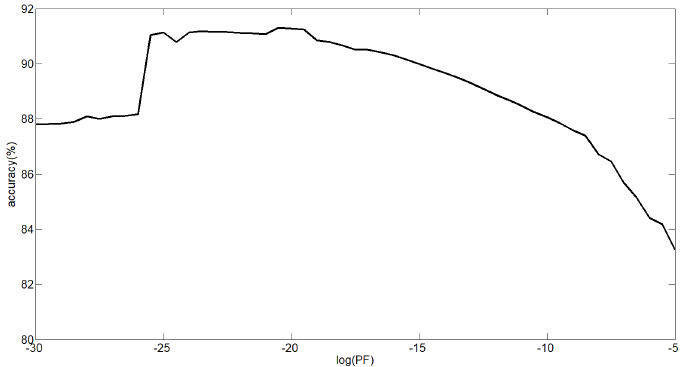
Figure 10. Parameter optimum for P F .